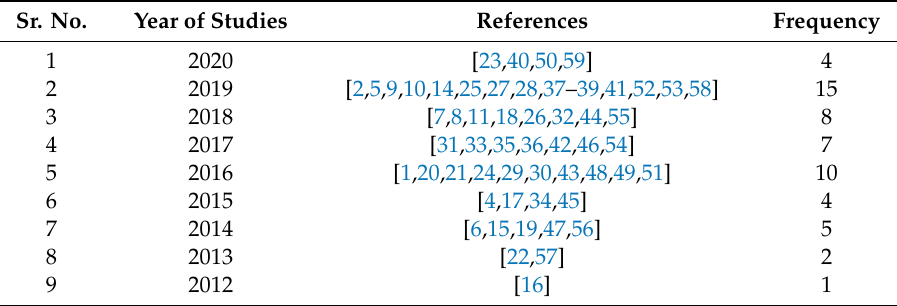
Table 3. Temporal View of Publications.